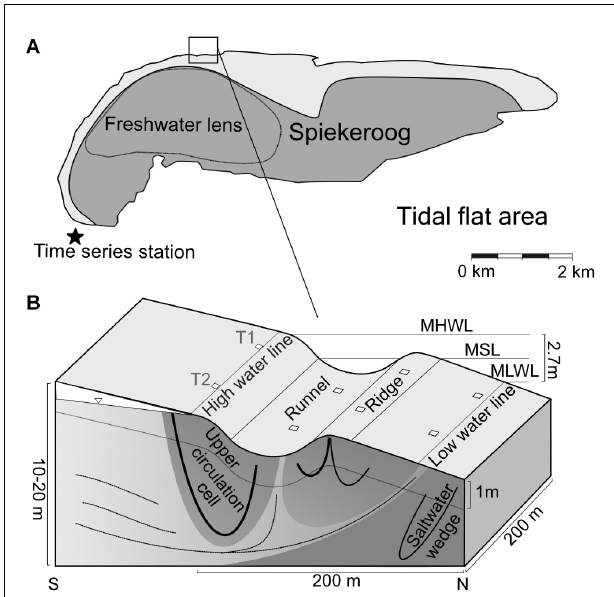
FIGURE 1 | Location of the sampling site at Spiekeroog Island modified after Ahrens et al. (2020b). (A) The dashed line indicates the dimensions of the fresh water lens. The time series station in the tidal inlet (indicated by a star) monitors various sea water constituents. (B) The lower panel displays a cross-section through the beach, including hydrological flow paths and beach morphology. T1 and T2 indicate transects sampled across the intertidal area, the squares mark the sampling sites. MHWL, mean high water line; MSL, mean sea-level; MLWL, mean low water line.